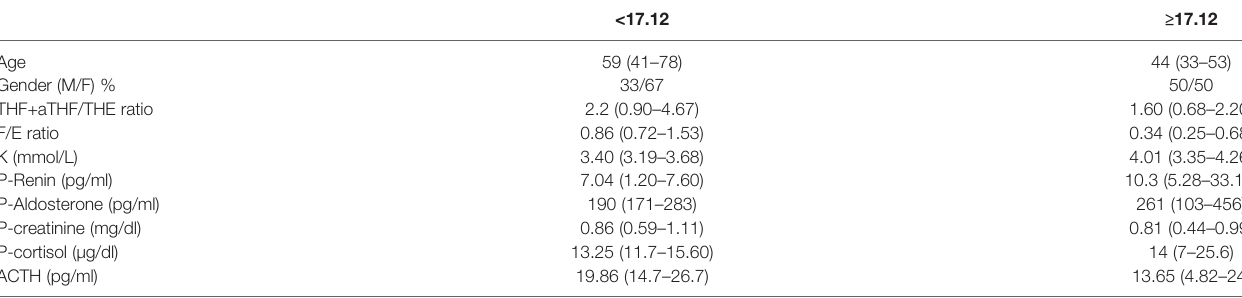
TABLE 3 | Characteristics of EH patients divided into low and high HSD11B2 mRNA copy number*.